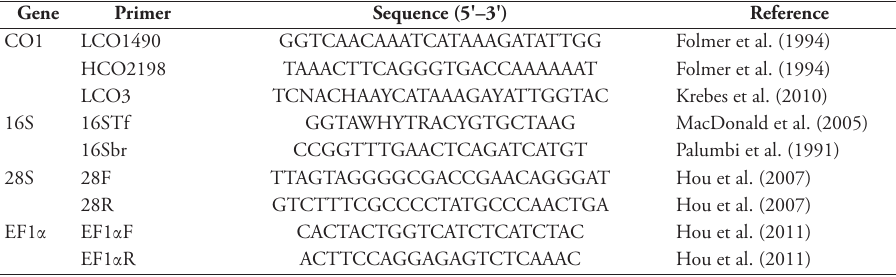
Table 1. Primer sequences of PCR products for target genes.